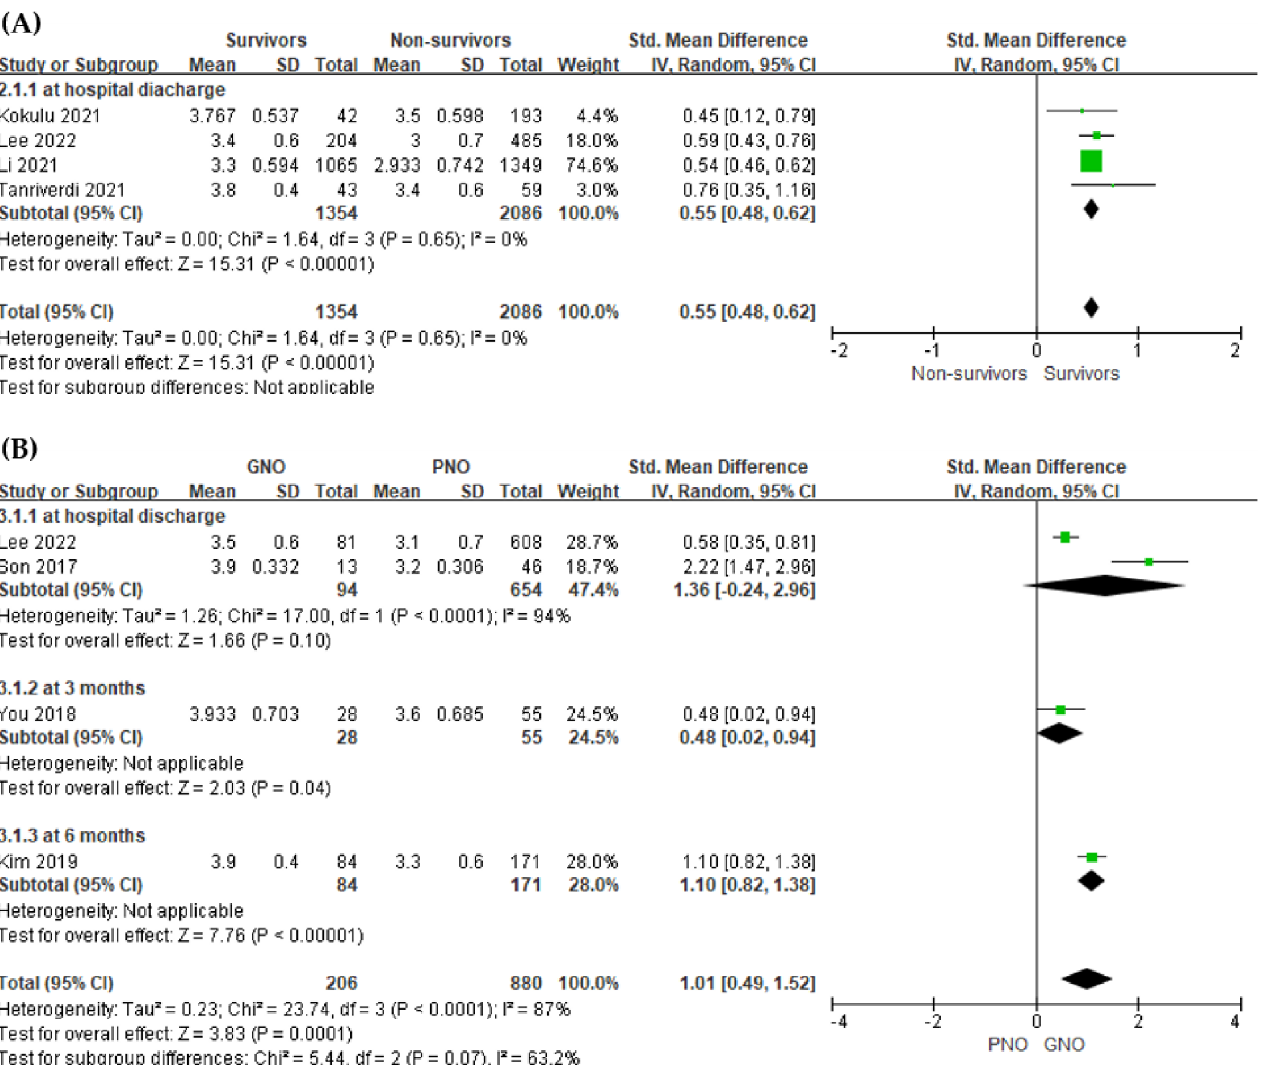
Figure 2. Forest plot of the association between the early phase serum albumin level and outcomes of post-cardiac arrest patients. ( A ) in-hospital mortality ( B ) neurologic outcome.